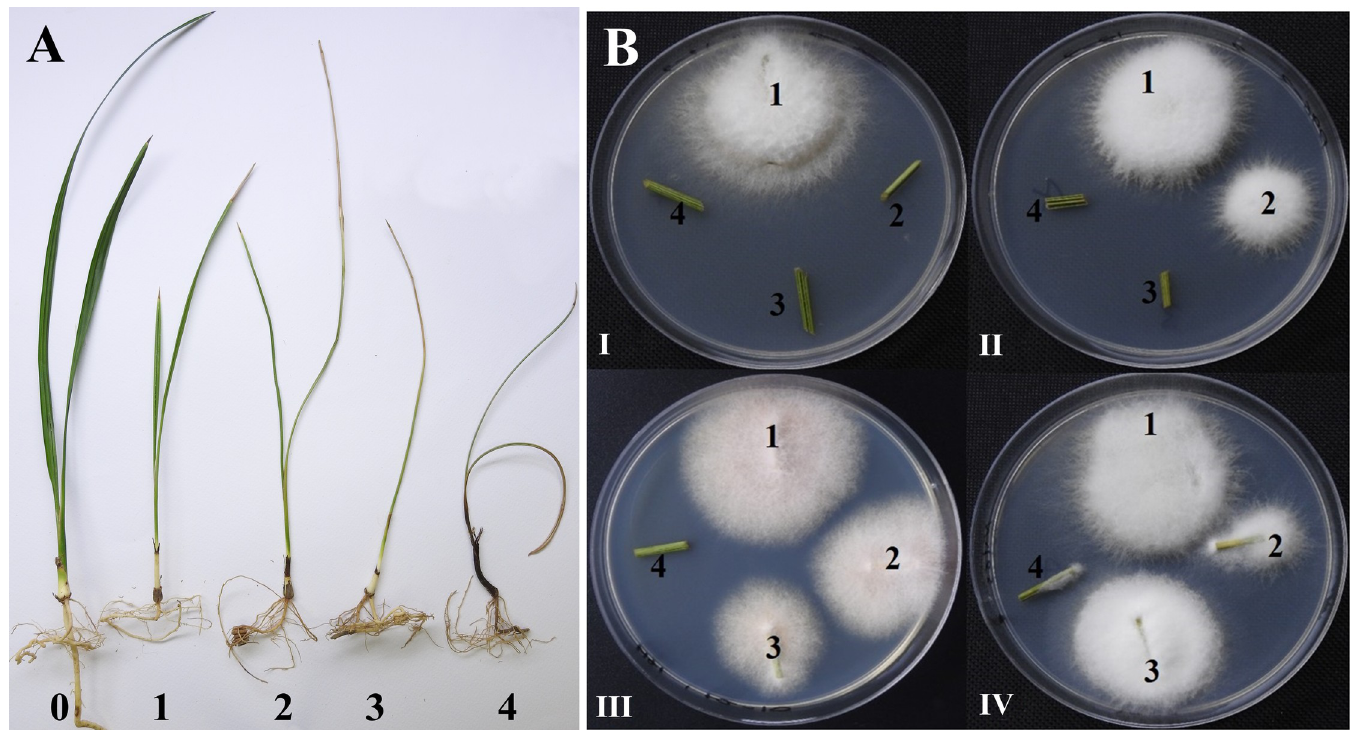
Fig 1. (A) Disease severity rating scale, (B) Reisolation of Fusarium strains from above-ground parts of inoculated date palm seedlings. (A) Disease severity rating scale from 0 to 4 according to the visible symptoms on Sheeshee seedlings inoculated with different strains of F . proliferatum , where 0 = healthy (no observable disease symptoms), 1 = shrinking of one leaf, 2 = stunting and shrinking of one or two leaves, 3 = stunting and shrinking of two leaves with one leaf died, 4 = completely dead seedling. (B) Reisolation of Fusarium strains from above-ground parts of inoculated seedlings. The average recovery of a fungal strain was calculated by summing plant pieces that showed the fungal growth and divided by the total number of pieces used for fungal isolation. Plates I, II, III, and IV show average recovery values of 1, 2, 3, and 4, respectively, for different Fusarium